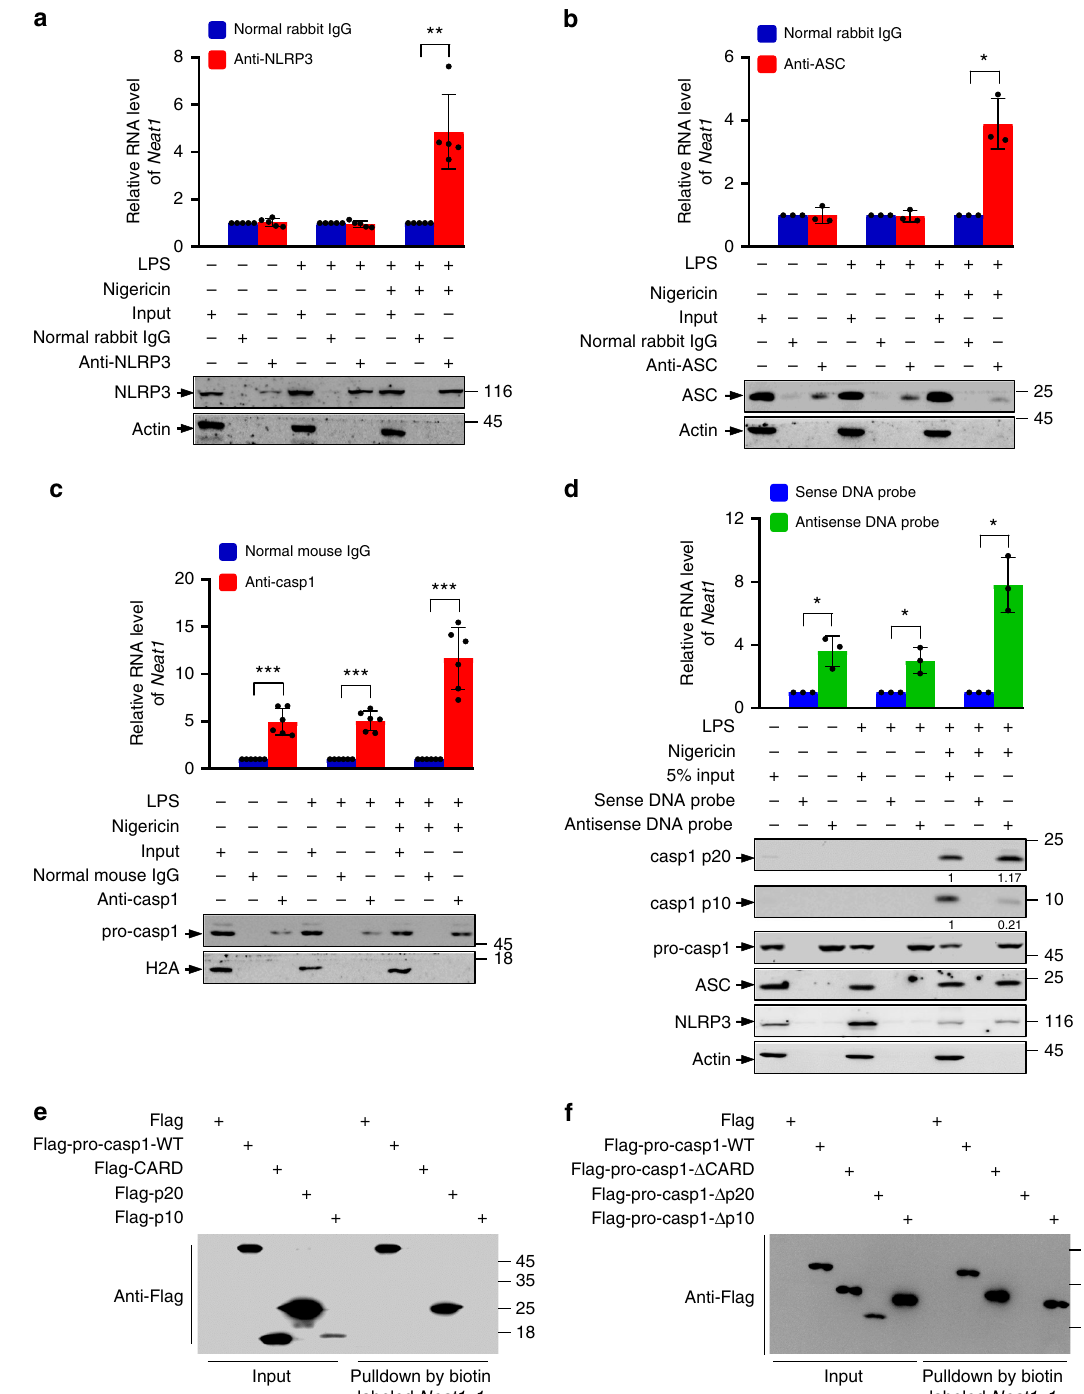
Fig. 4 Neat1 interacts with caspase-1 p20 domain. a – c Cell lysates of normal iBMDMs, LPS-primed iBMDMs or LPS-nigericin-co-stimulated iBMDMs were incubated with normal rabbit IgG ( a – c ), NLRP3 antibody ( a ), ASC antibody ( b ), or caspase-1 antibody ( c ) for RIP. The immunoprecipitates were analyzed by real-time RT-PCR to exam enrichment ef fi ciency of Neat1 and by Western blotting for protein levels. d Cell lysates of normal, LPS-primed, or LPS- nigericin-co-stimulated iBMDMs were incubated with biotin-labeled Neat1 sense or antisense DNA probes immobilized on beads. The precipitated samples were analyzed by real-time RT-PCR for Neat1 contents, and by western blotting for indicated protein levels. e In vitro transcribed biotin-labeled Neat1_1 was incubated with lysates extracted from 293T cells expressing Flag-tagged wild-type pro-caspase-1, CARD, p20, or p10 for 3 h. The input and biotin pull- down samples were then carried out to western blotting. f In vitro transcribed biotin-labeled Neat1_1 was incubated with lysates extracted from 293T cells expressing Flag-tagged wild-type pro-caspase-1 or the indicated deletion mutants for 3 h. The input and biotin pull-down samples were analyzed by western blotting. In a , data shown are mean ± SD ( n = 5). In b and d , data shown are mean ± SD ( n = 3). In c , data shown are mean ± SD ( n = 6). * P < 0.05, ** P < 0.01, two-tailed t -test. Source data are provided as a Source Data fi